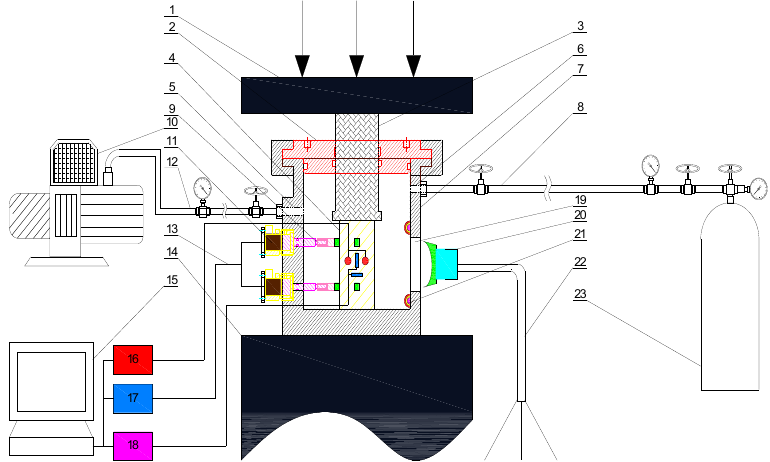
Figure 1. Experimental system of multi-data acquisition during loading process of gas-bearing coal. Number of parts in experimental system of Figure 1.